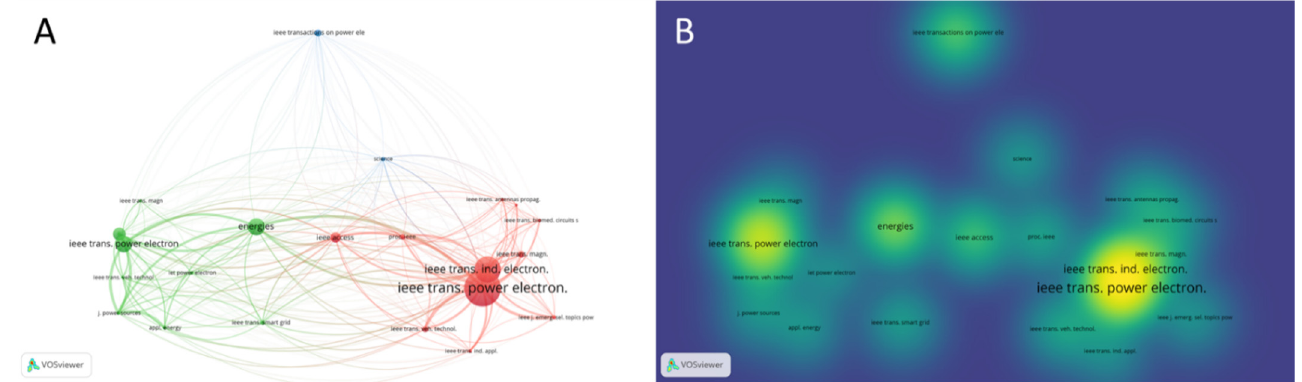
Figure 9. Co-citation analysis for sources. Network ( A ) and density visualization ( B ) showed 33 out of 15,095 sources met the threshold of 200 citation counts. The maps had three clusters and 243 links.